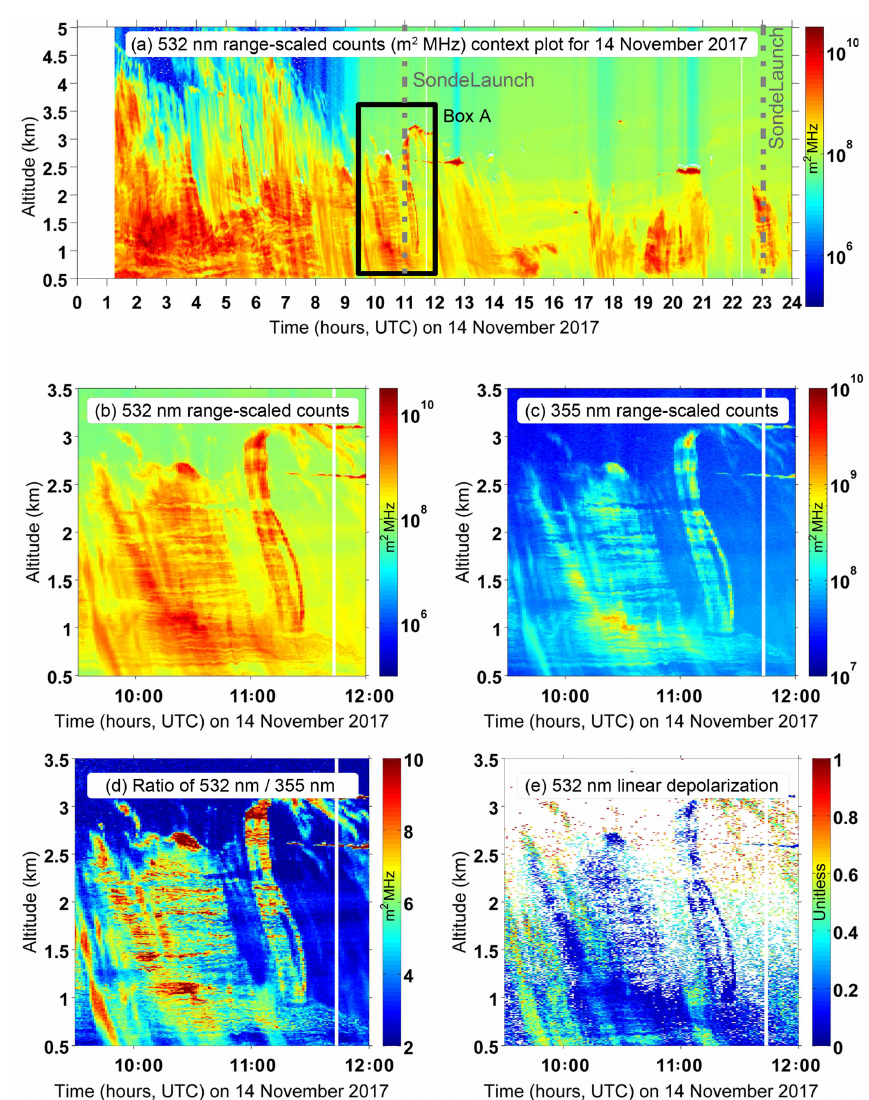
Figure 6. Measurements from 14 November 2017; panels (a–e) same format as Fig. 4. Thick clouds were present early in the day with cloud cover reducing later. Layers which start in a cloud continue in the next section of cloud, even if there is a gap in between. Precipitation alternated between light snow, blowing snow, ice crystals, and no precipitation at the ground throughout the